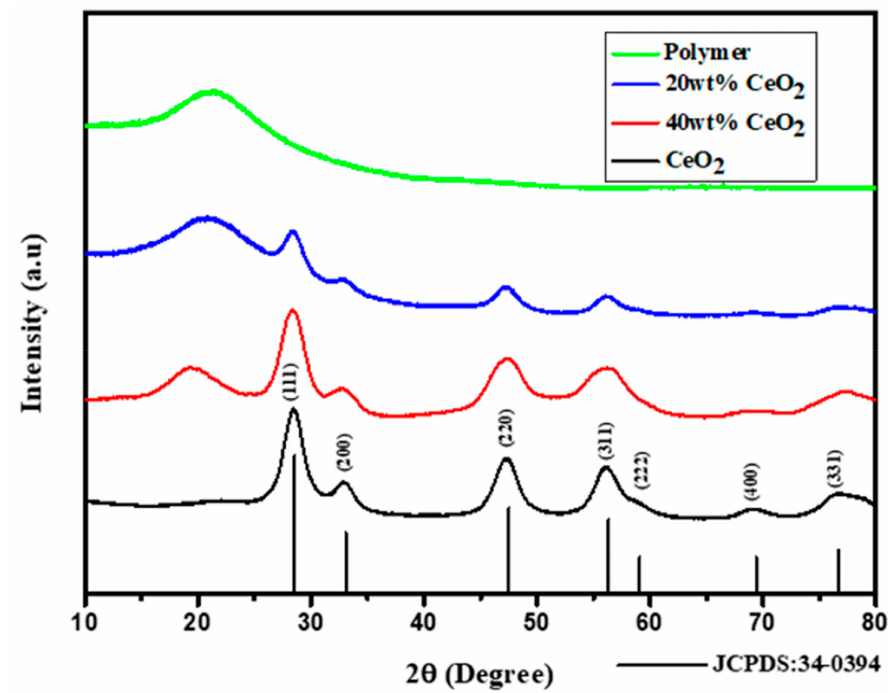
Figure 1. X-ray di ff raction (XRD) pattern of polymer composite with 20 wt% and 40 wt% CeO 2 nanoparticles